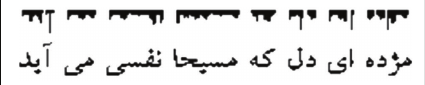
Figure 10: Vertical histogram